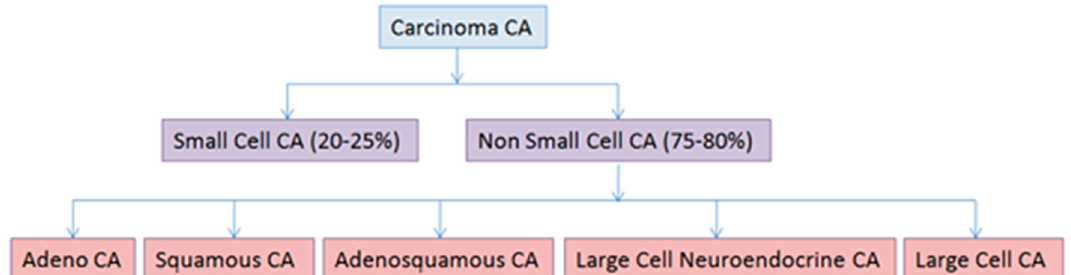
Figure 1. The new World Health Organization (WHO) classification of lung cancer histological types. The various types of lung cancer have different origins and histological features (Figure 2). Small-cell lung carcinoma (SCLC) is characterized by small size cells, absence of differentiation, fast tumor growth, metastasis at early stages, and release of specific biomarkers and hormones. At present, there are two points of view on SCLC histogenesis. According to the first hypothesis, SCLC arises from cells of the diffuse endocrine system, i.e., the amine precursor uptake decarboxylation (APUD)-system (Figure 2); the second suggests this type of lung cancer originates from the endodermbronchial lining layer [10]. CA: carcinoma.